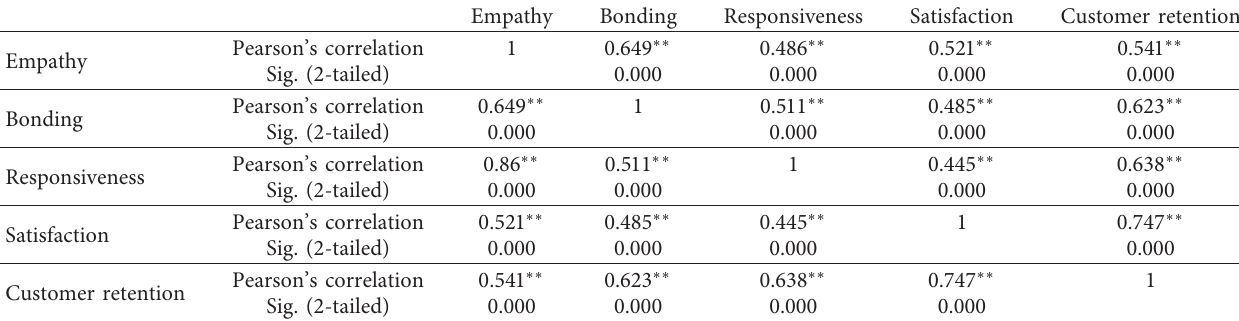
Table 3: Correlation analysis